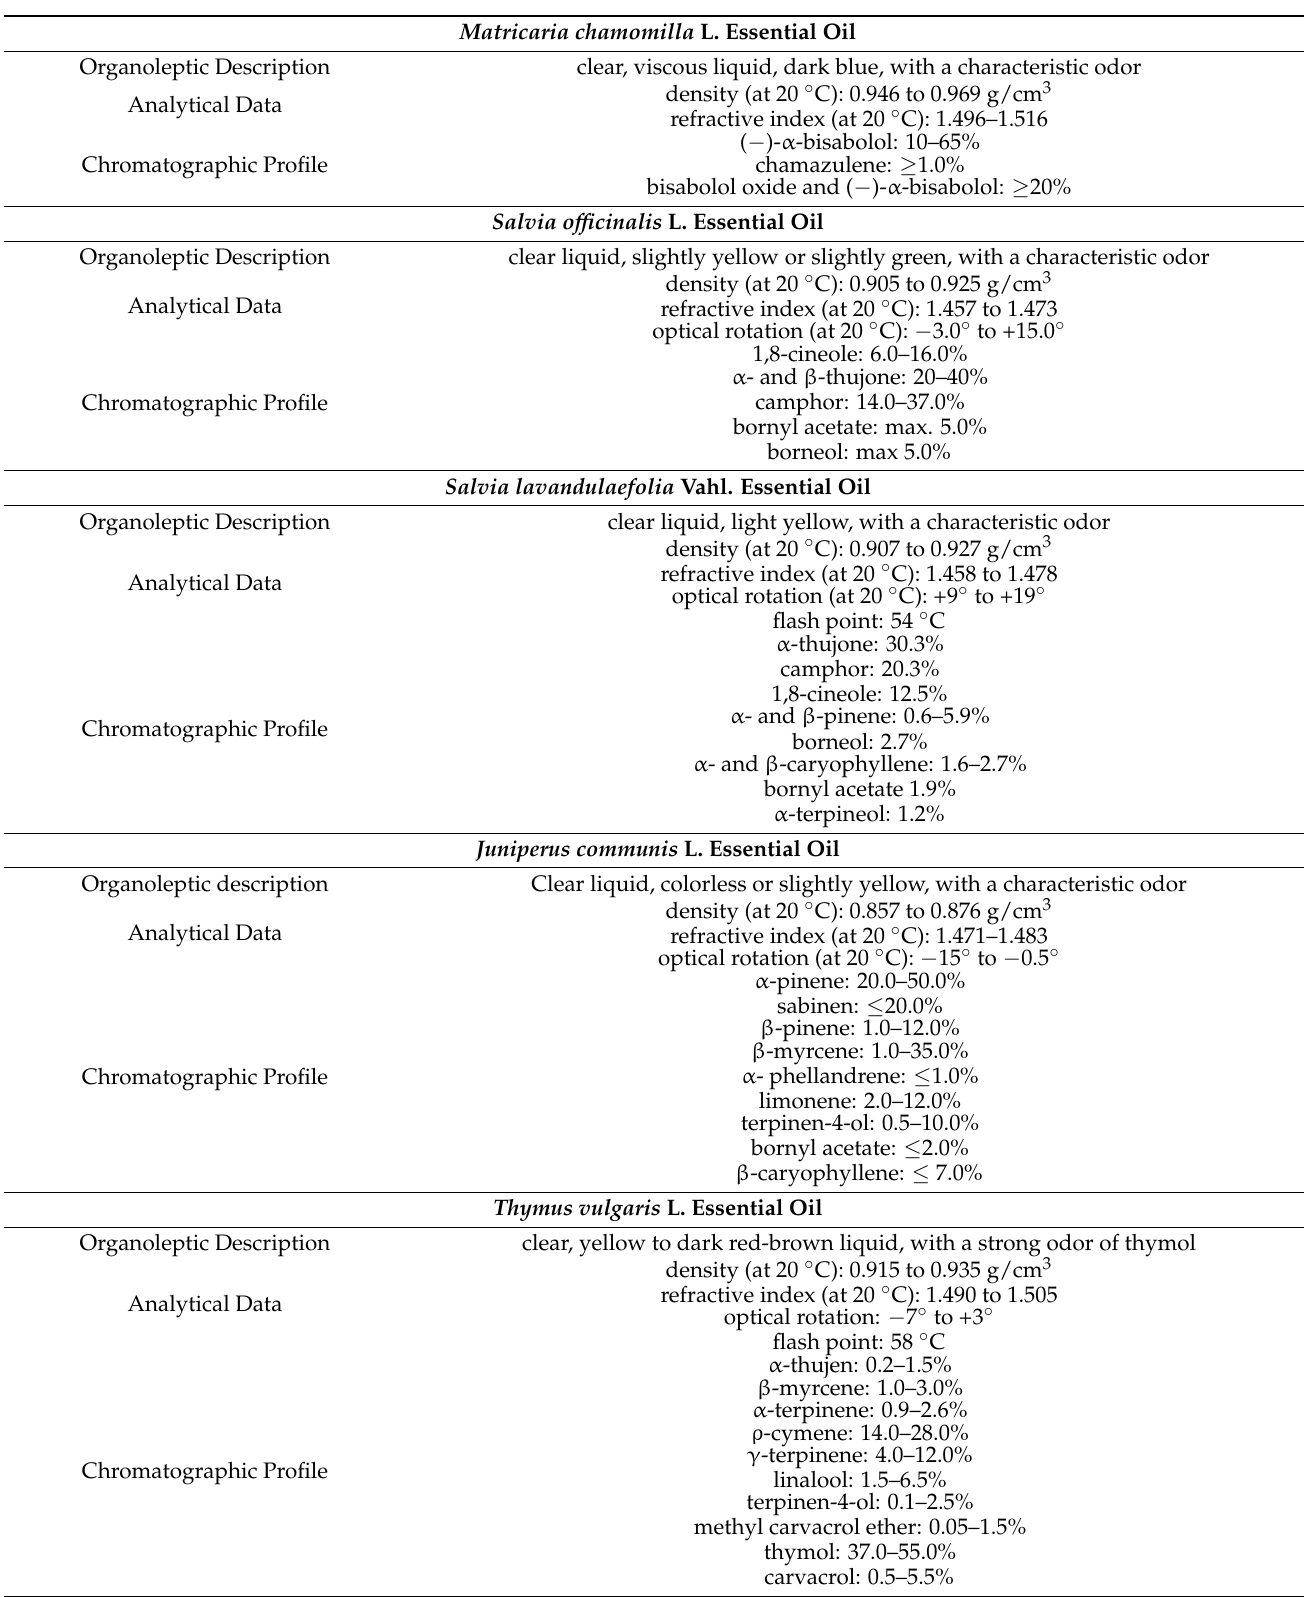
Table 3. Characteristics of essential